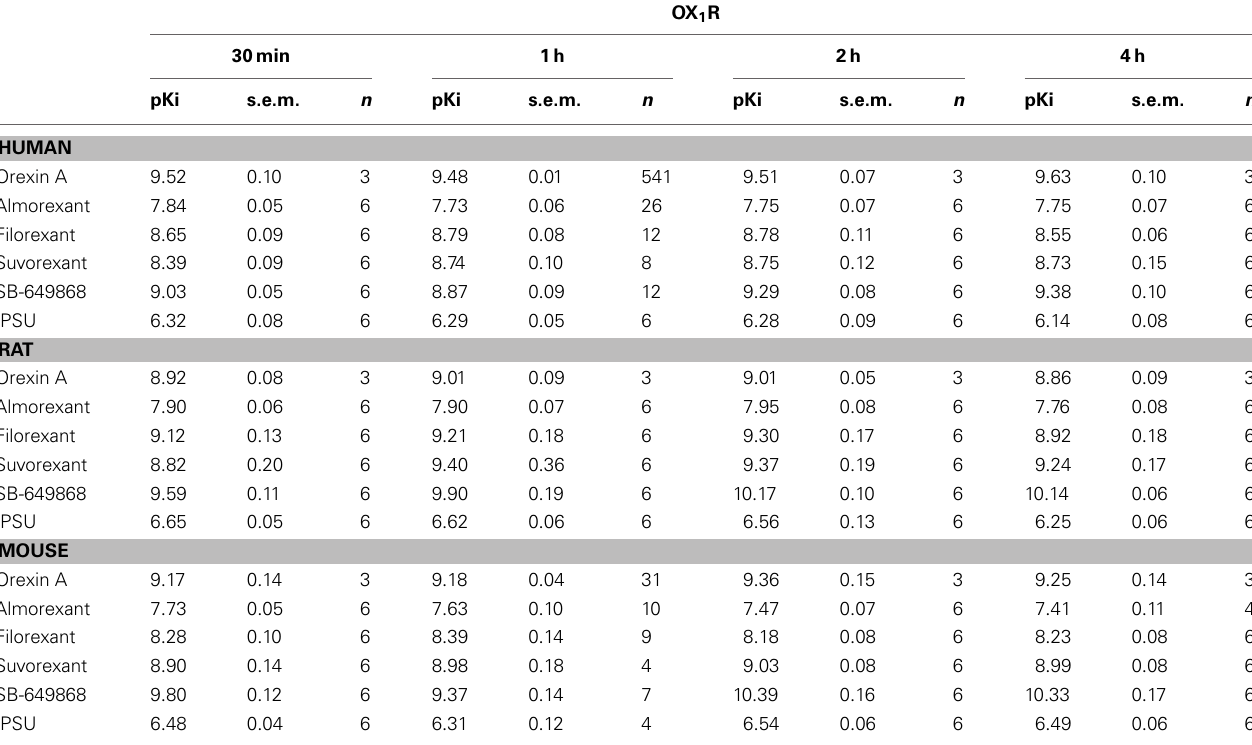
Table 1 | Ca 2 + signaling in cells stably transfected with human (CHO), rat (HEK) or mouse (HEK) OX 1 R in the presence of the endogenous agonist (orexin A) or putative dual orexin receptor antagonists (almorexant, filorexant, suvorexant, SB-649868, and